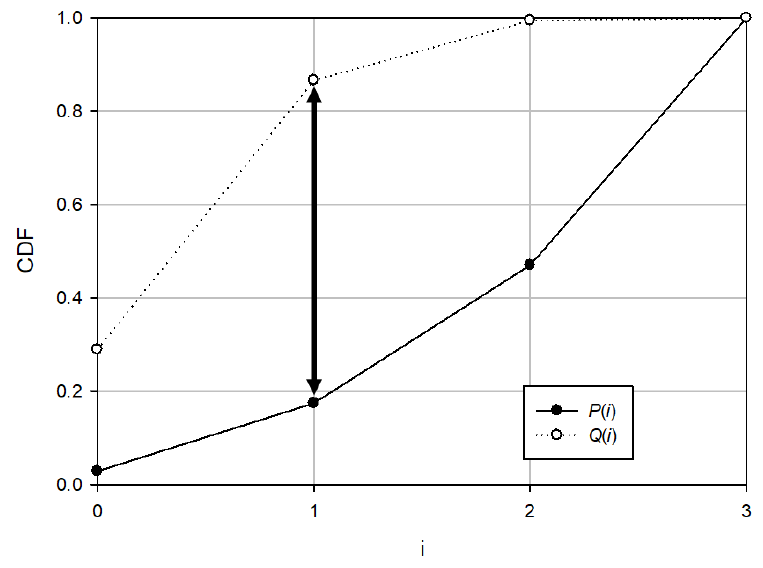
Figure 3. Illustration of the K–S statistic. The black arrow is the two-sample K–S